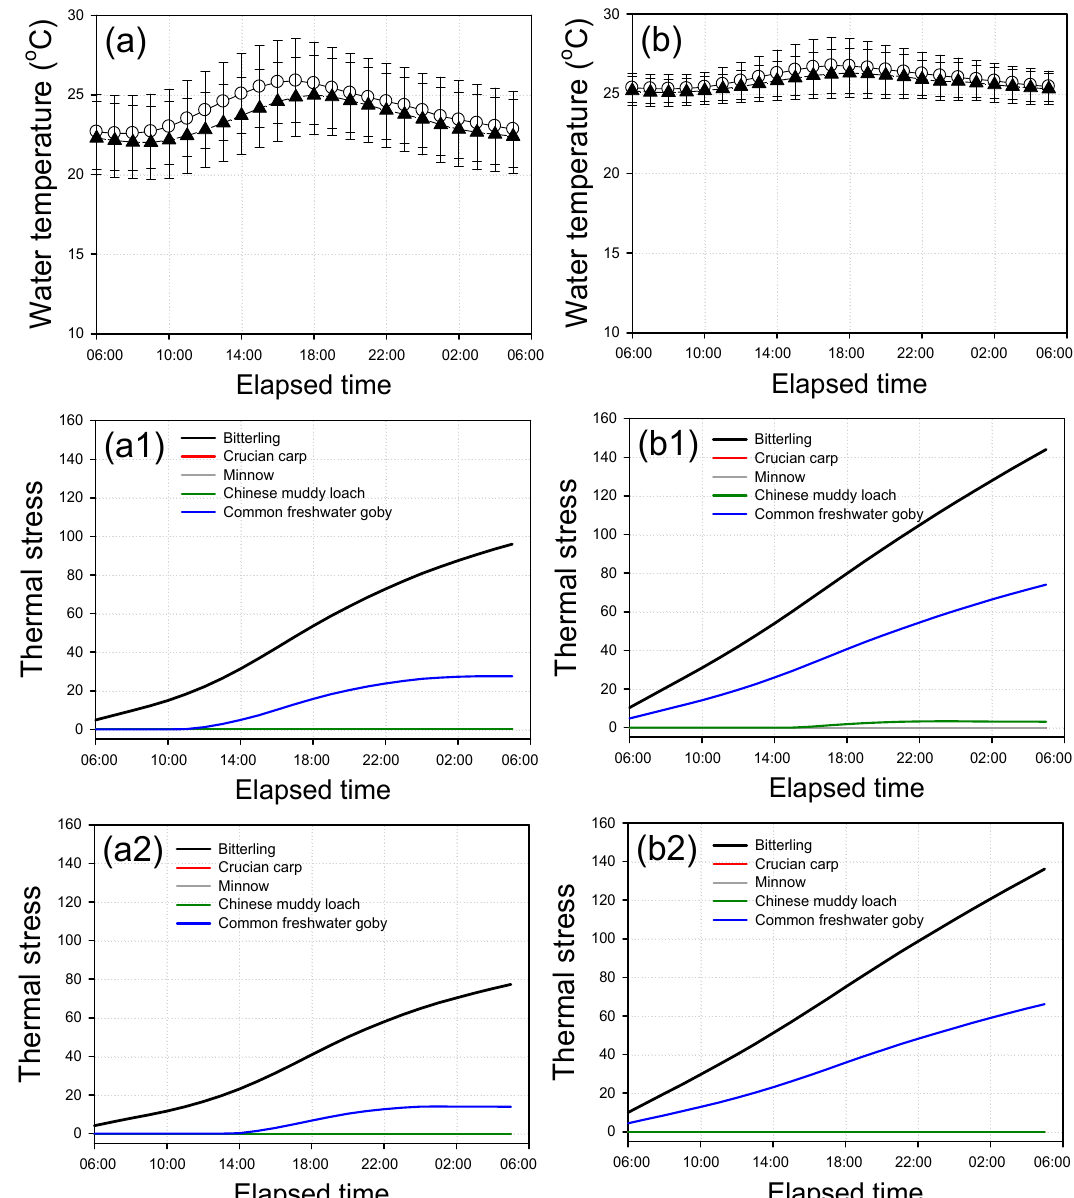
Figure 7. Diurnal variations in the average water temperature and thermal stress for the fish fauna inhabiting the study site in 2013. ( a ) Normal season. ( b ) Rainy season. ( a1 ) Thermal stress for various fish fauna in St. 1 in the normal season. ( a2 ) Thermal stress for various fish fauna in St. 2 in the normal season. ( b1 ) Thermal stress for various fish fauna in St. 1 in the rainy season. ( b2 ) Thermal stress for various fish fauna in St. 2 in the rainy season. Crucian carp showed ND.